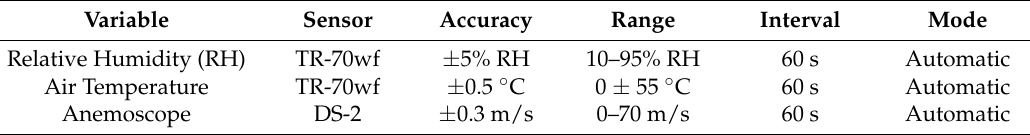
Table 1. The measured variables and technical data of the